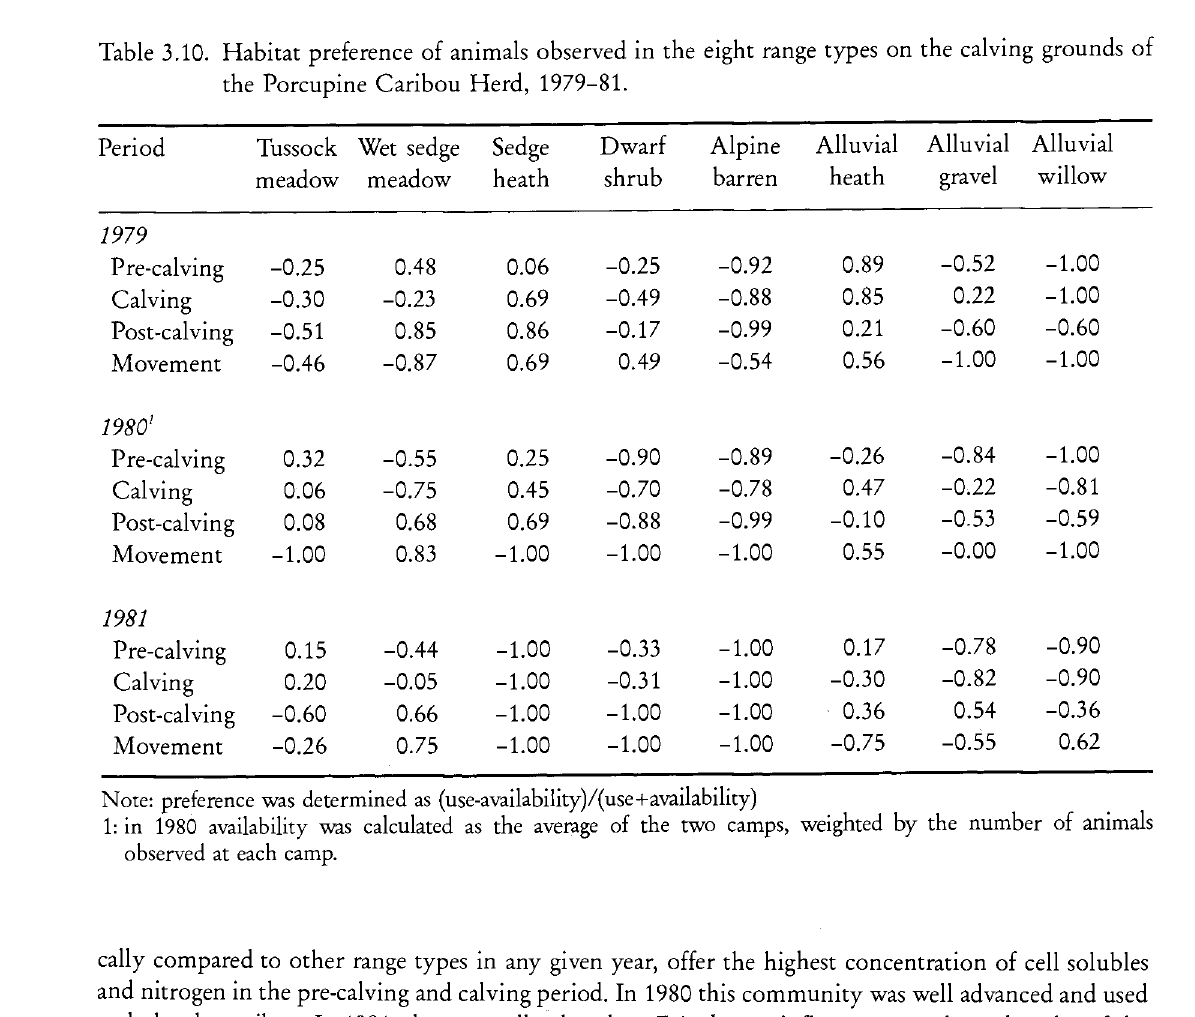
Table 3.10. Habitat preference of animals observed in the eight range types on the calving grounds of the Porcupine Caribou Herd,